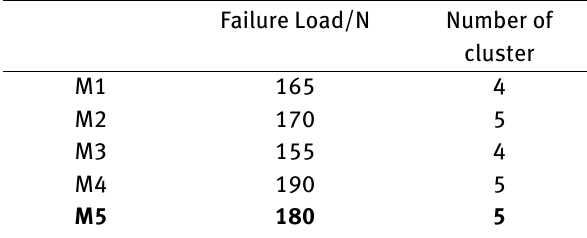
Table 6: List and result of C/SiC mini-composite tensile